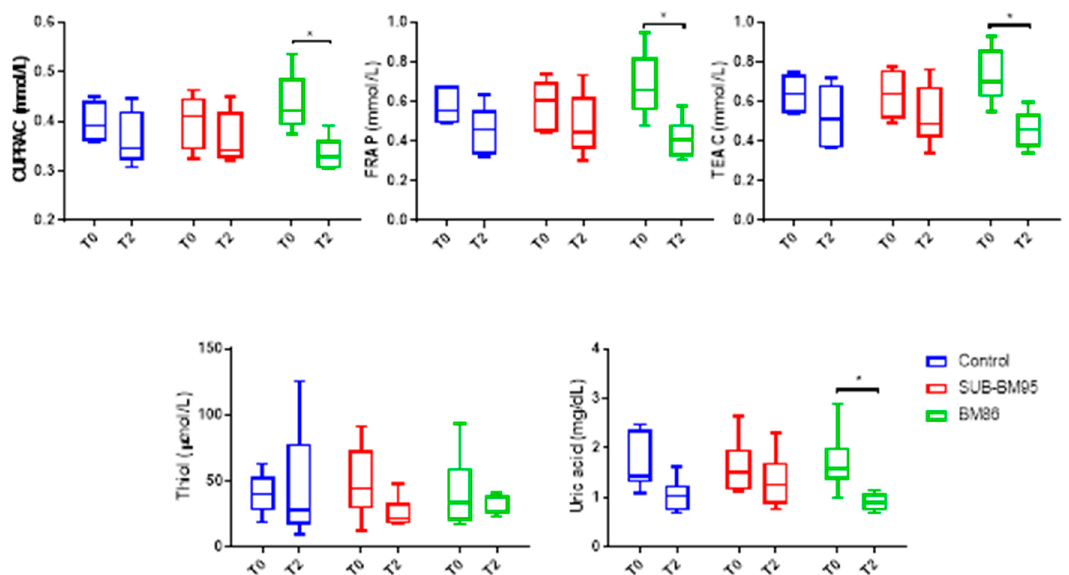
Figure 2. Values of antioxidant markers in vaccinated cattle with BM86, SUB-BM95, and control at T0 and T2. CUPRAC, cupric reducing antioxidant capacity; TEAC, trolox equivalent antioxidant capacity using horseradish peroxidase; FRAP, ferric reducing ability of plasma; total serum thiols and uric acid. The plots show median (line within box), 25th and 75th percentiles (box) and minimum and maximum values (whiskers). Asterisks indicate significant differences between times and immunization * p < 0.05.